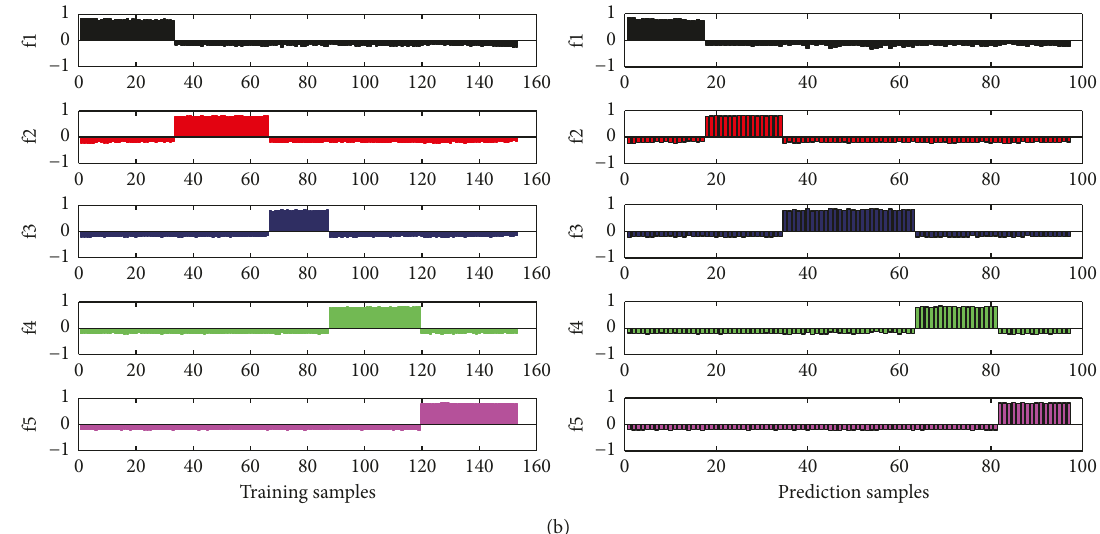
Figure 4: Assigned plots of dummy codes of the training set and prediction set for the raw fusion MIR-NIR spectra in the PLSDA model (a) and the MWPLSDA (b)